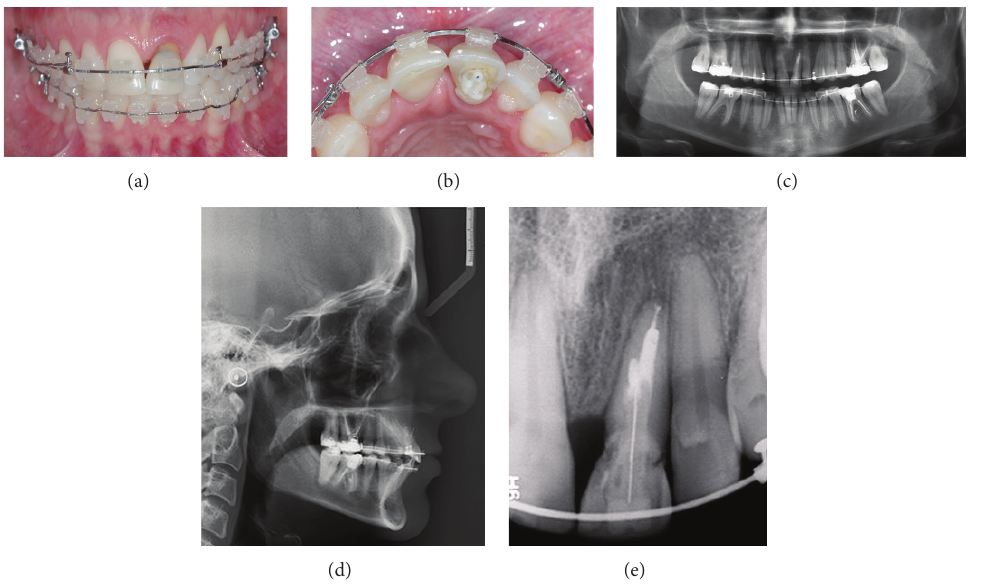
Figure 6: (a, b) Clinical images illustrating orthodontic extrusion after eight months; (c) panoramic radiography; (d) cephalometric radiography; (e) periapical radiography.